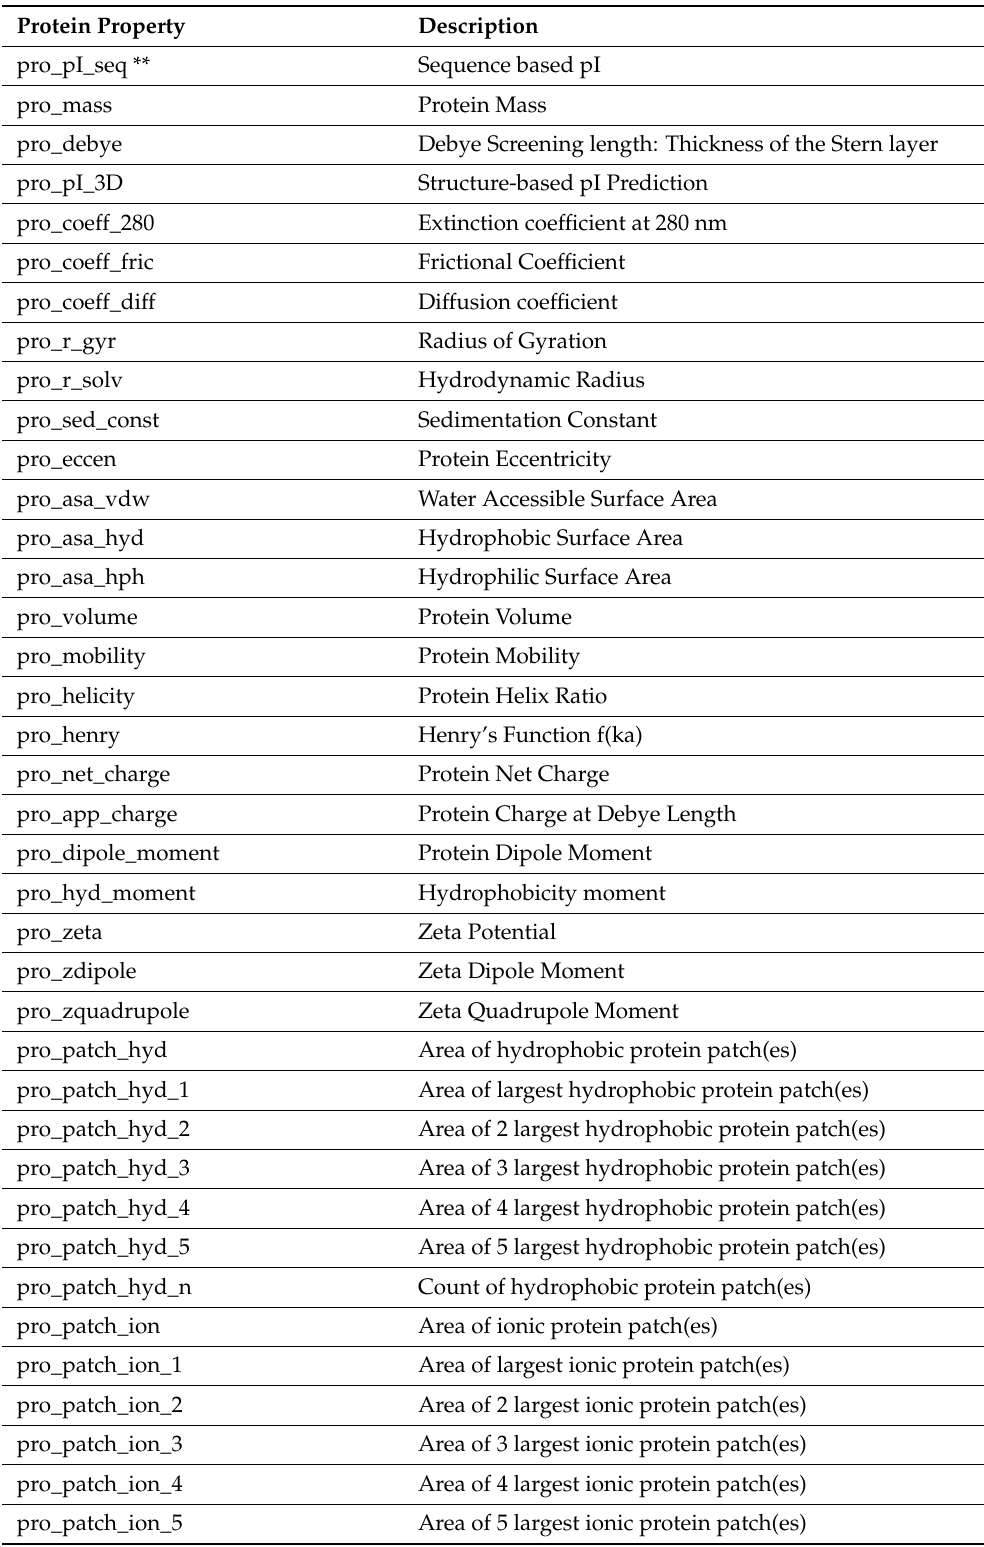
Table 1. Describes the protein descriptors for ADORA2A, ADRB2 and OPRK1 datasets. The molecular descriptors were calculated using the protein descriptors of the program MOE